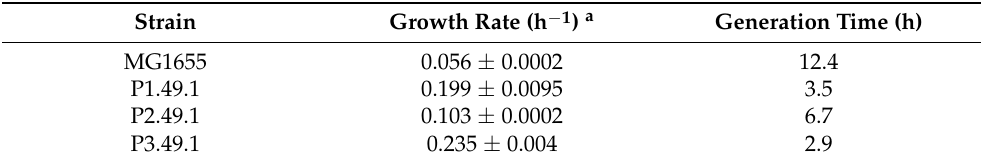
Table 1. Growth rates of parental and evolved E. coli